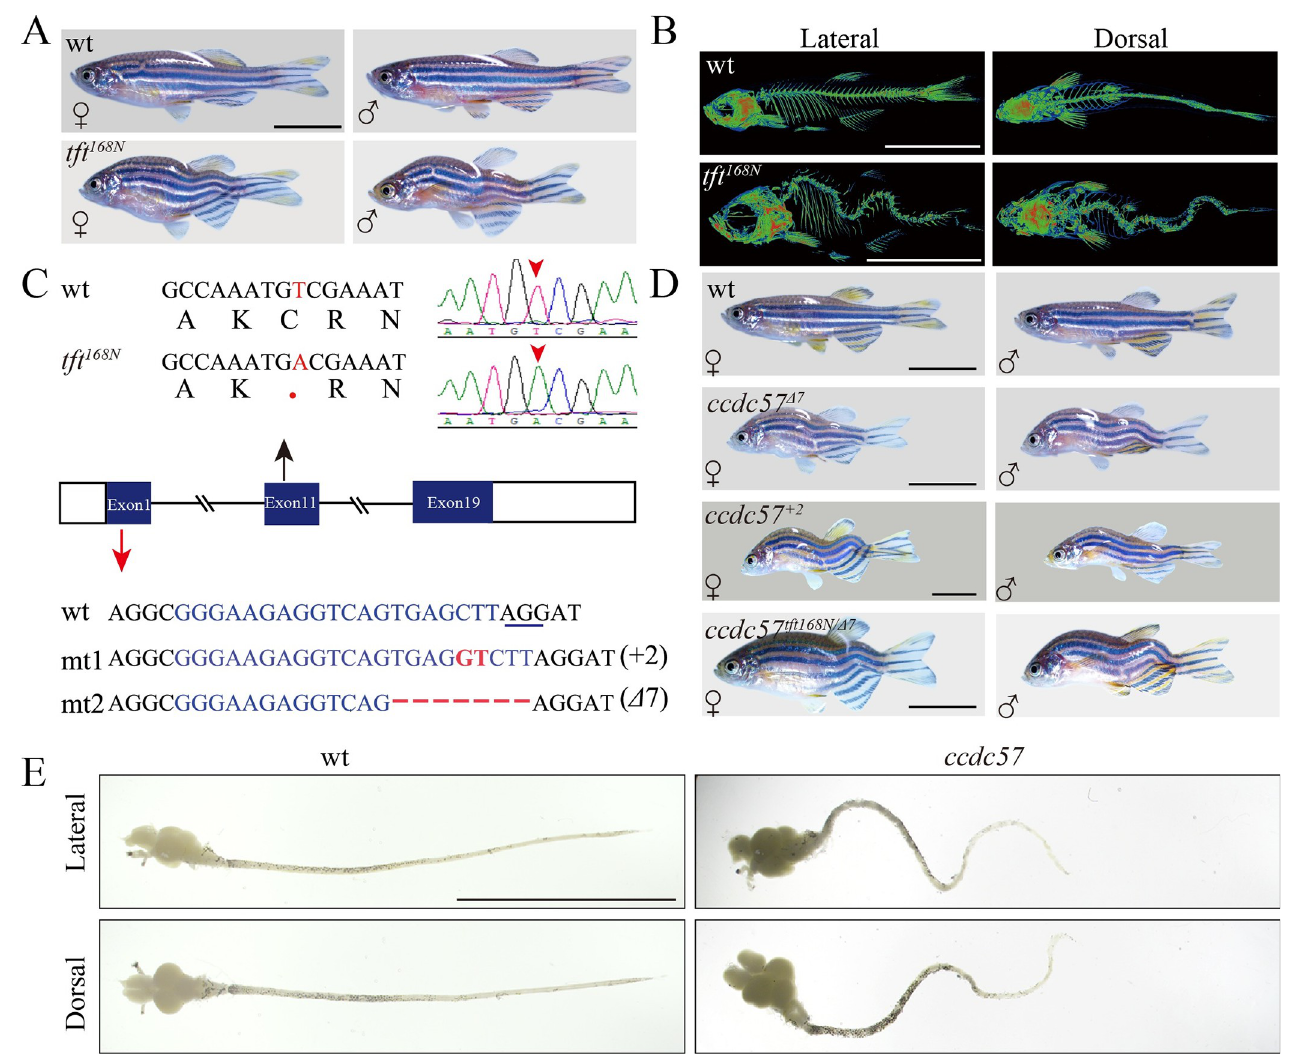
Fig 1. Mutation of ccdc57 leads to scoliosis. ( A ) Representative images of male and female wild type and tft 168N mutants. ( B ) Micro-CT images showing lateral and dorsal views of 3-months-old wild type and tft 168N mutants. ( C ) Genomic structure and sequences of wild type, tft 168N mutant and two ccdc57 mutant alleles generated with CRISPR/Cas9. The underlined sequence in wt indicates PAM sequence of sgRNA target. ( D ) Representative images of male and female wild type and ccdc57 mutants with different genetic background as indicated. ( E ) The dissected brain and spinal cord in wild type and ccdc57 mutant. Scale bars: 1 cm in panels A, B, D,